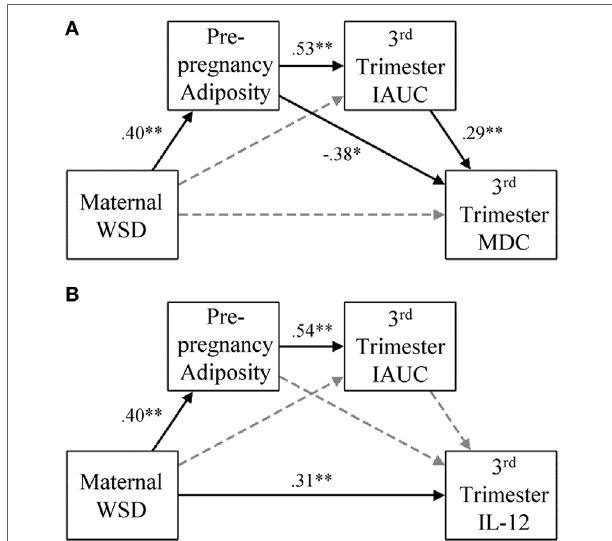
FigUre 2 | Gestational MDC and IL-12 response and degree of metabolic impairment. (a) In the presented model for maternal third trimester MDC, paths were also estimated from maternal age at birth to prepregnancy adiposity ( β = 0.54, p < 0.001), third trimester IAUC ( β = − 0.02, p = 0.80), and maternal third trimester MDC ( β = 0.03, p = 0.80), but were not visually depicted for ease of readability. (B) In the presented model for maternal third trimester, IL-12 paths were also estimated from maternal age at birth to prepregnancy adiposity ( β = 0.54, p < 0.001), third trimester IAUC ( β = − 0.03, p = 0.74), and maternal third trimester IL-12 ( β = − 0.08, p = 0.58), but were not visually depicted for ease of readability. Black lines indicate significant direct effects ( p < 0.05) and are labeled with β value. See results for further details on model fit and indirect effects. Gray dashed lines indicate paths that were estimated but were not statistically significant. WSD, Western-style diet; IAUC, insulin area under the curve; IL, interleukin. *p < 0.05 and ** p <